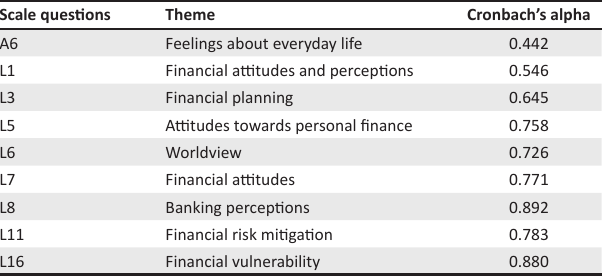
TABLE 3: Reliability results of the FinScope questionnaire. Scale questions